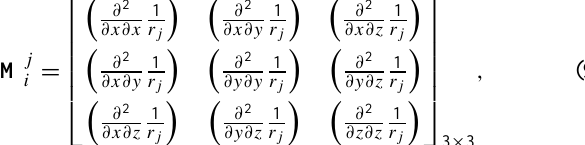
Figure 2. Schematic representation of the vector h j (Eq. 12) with elements hx j , hy j and hz j in Cartesian coordinates. This vector has a declination D j (positive in the clockwise sense) and inclination I j (positive downward), j = 1 ,...,L